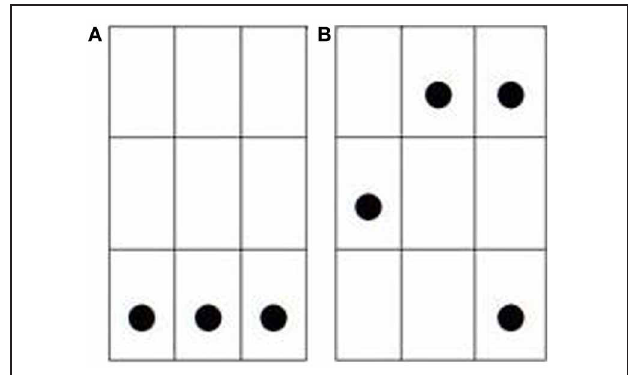
FIGURE 1 | Examples of dot patterns used in (A) LOW LOAD and (B) HIGH LOAD trials.